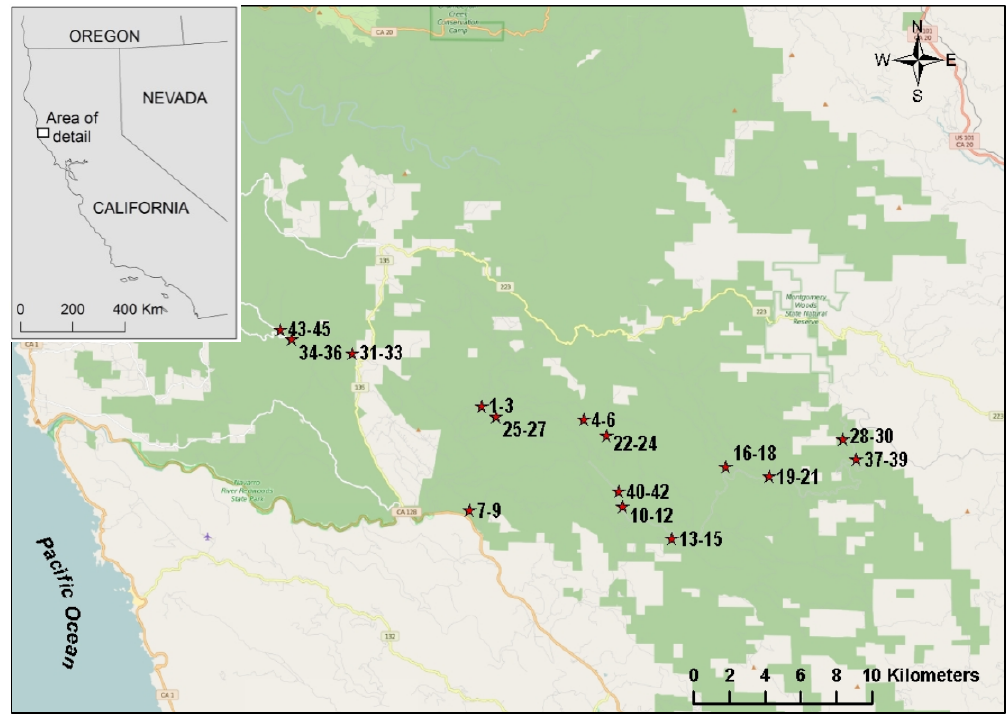
Figure 1. Distribution of sample plots across Mendocino Redwood Company timberlands in Mendocino County, California. Each point represents a group of three plots (one for each treatment type).